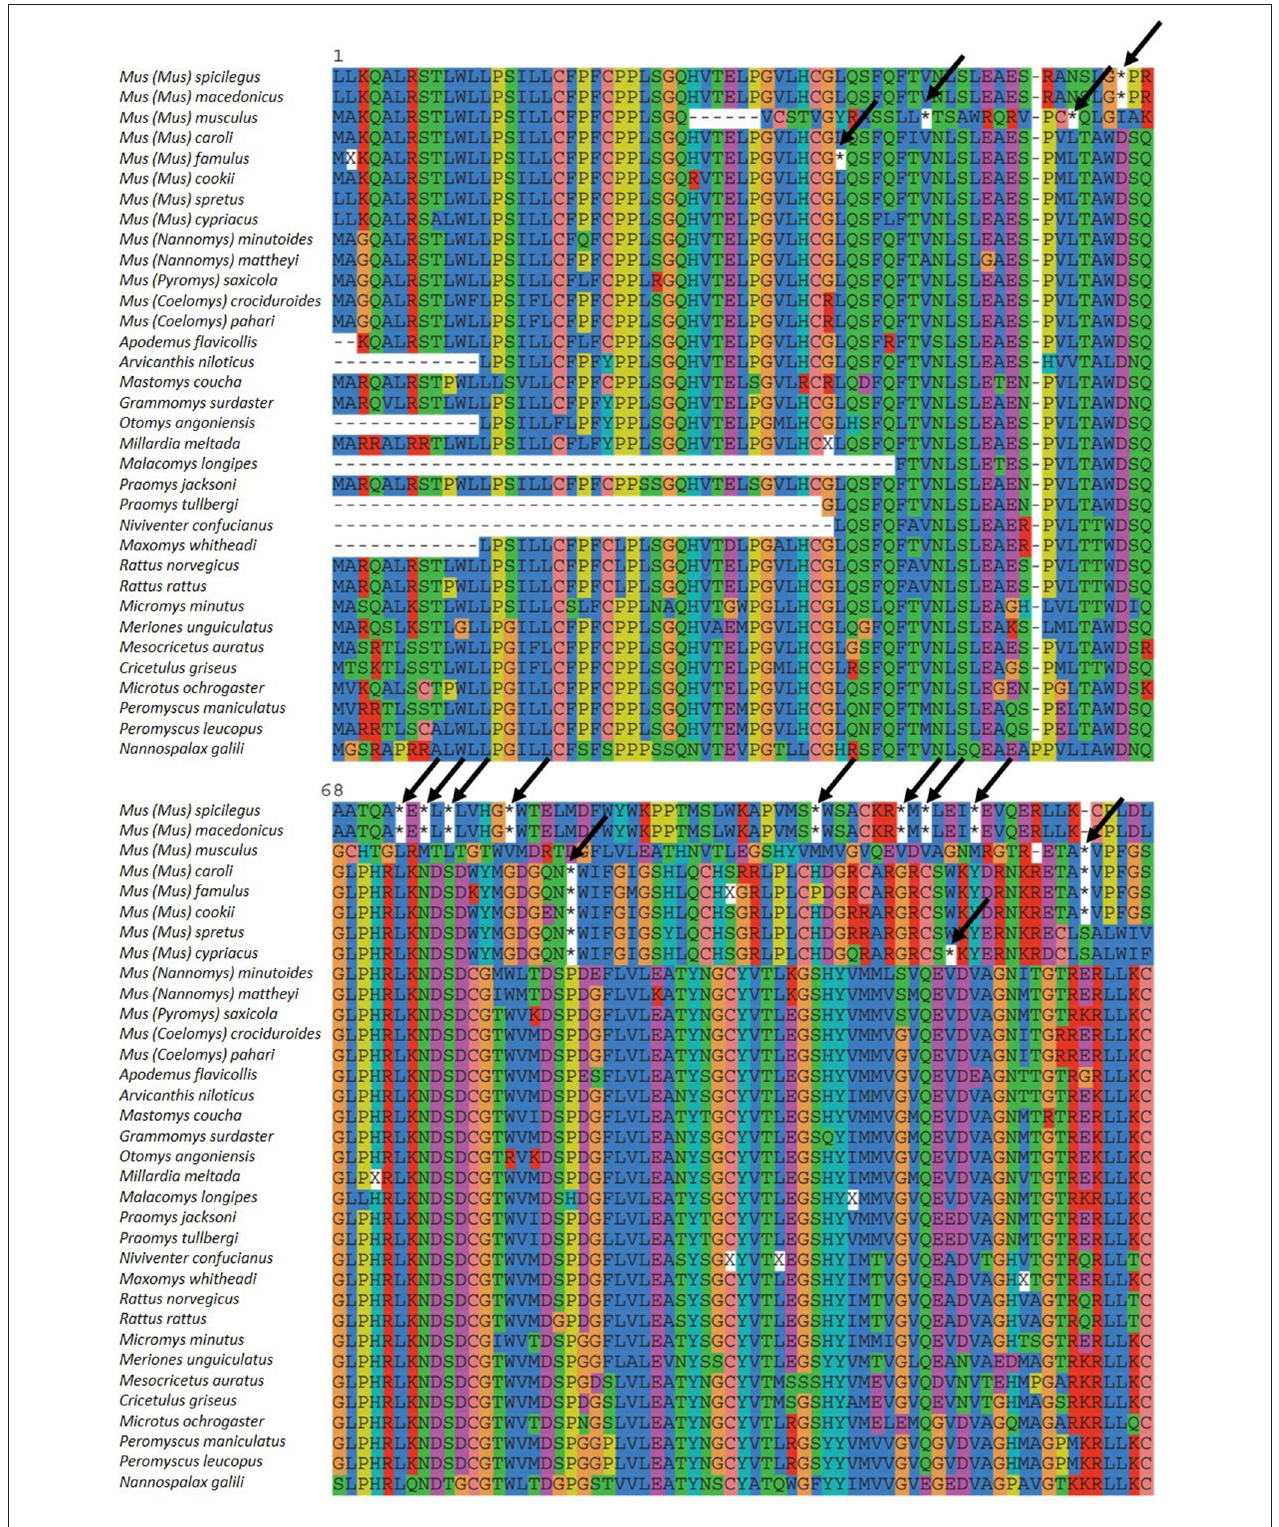
FIGURE 1 | Zp4 alignment of the different species analyzed. Initial methionine is signaled with 1. Stop codons are marked by an asterisk (*) and arrows.